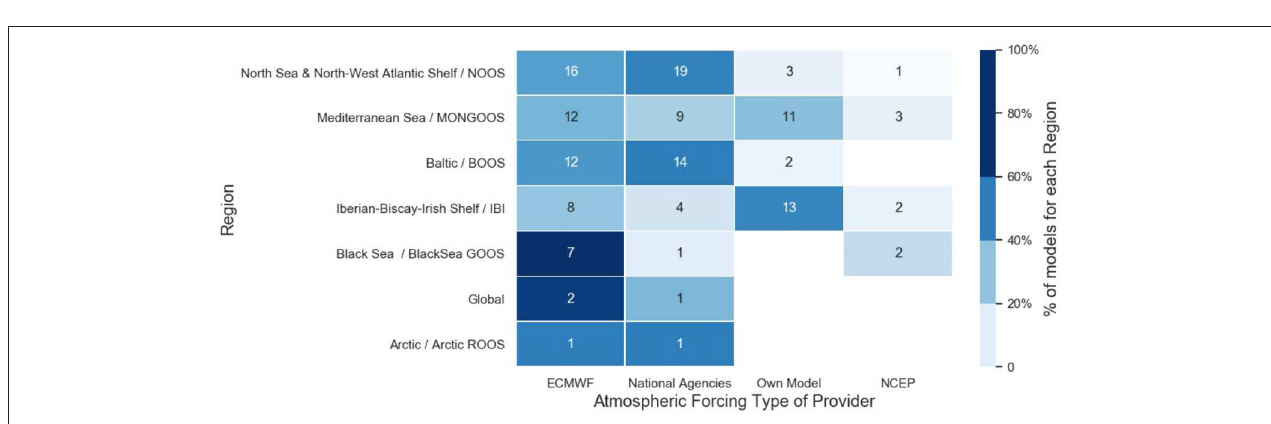
FIGURE 8 | Regional means of spatial resolution and shallowest bathymetry.